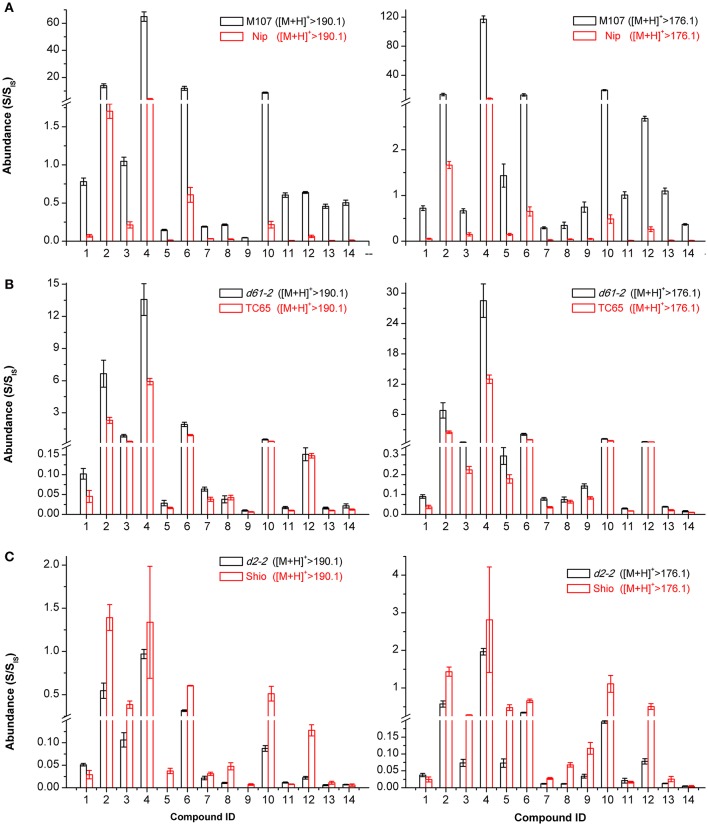
The quantitative levels of 14 BR candidates in rice BR mutants and their wild types. Nip (A), Shio (B), and TC65
(C) are wild type plants for M107 (A), d2-2
(B), and d61-2
(C) mutants, respectively. Samples were analyzed with three technical replicates from sample preparation to LC-MS/MS analysis. The compound abundances in plants were evaluated by the ratio of the integrated peak area of these compounds to that of the spiked D-labeled internal standards (S/SIS). The endogenous levels were quantified using two ion channels [M+H]+ > 190.1 and [M+H]+ > 176.1. Error bars represent the SD.